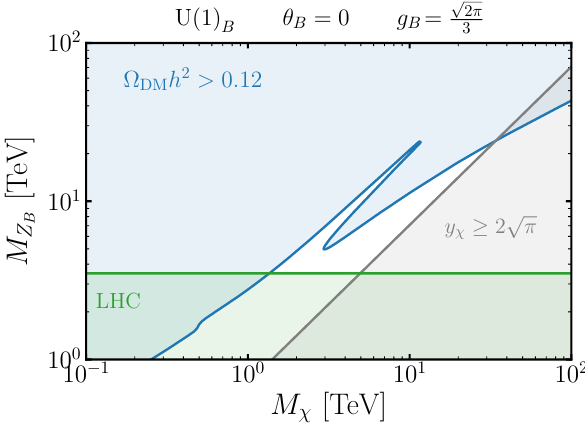
Figure 5 . Parameter space allowed by the relic density constraint, LHC bounds and perturbative √ bounds for the maximal gauge coupling g B = 2 π/ 3 . We take M h = 500 GeV and no mixing B angle. The region shaded in blue is excluded by the relic density constraint Ω DM h 2 ≤ 0 . 12 and the region in gray is excluded by the perturbative bound on the Yukawa coupling y χ . The region shaded in green is excluded by the LHC bounds on the leptophobic gauge boson